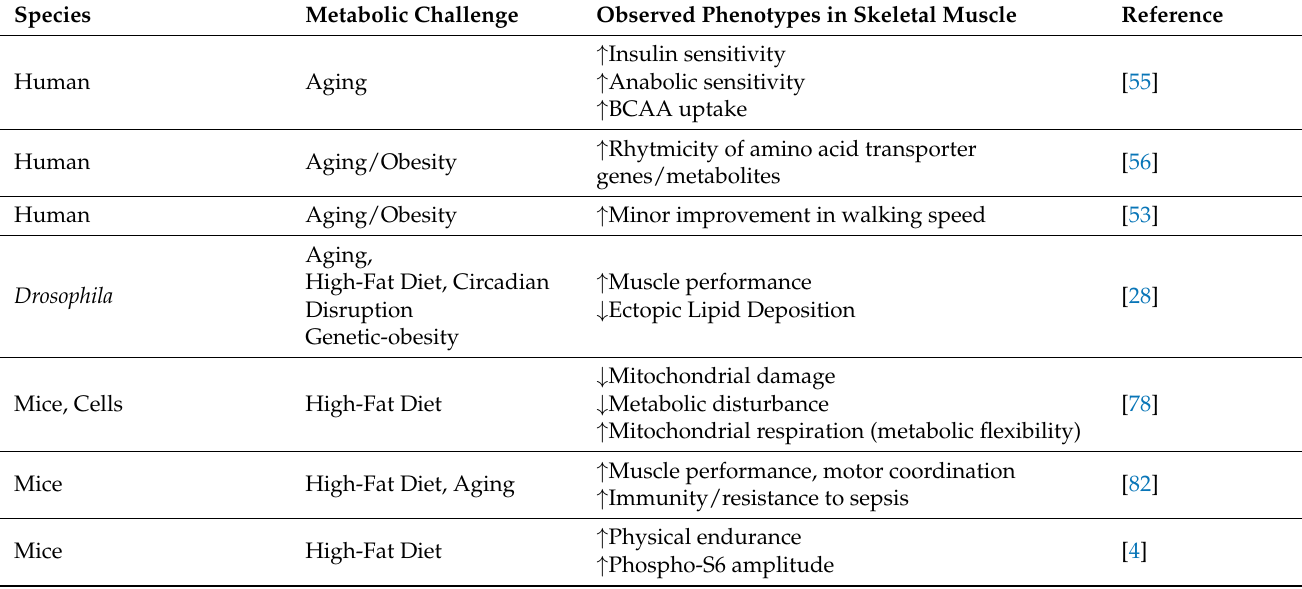
Figure 2. Muscle-specific TRE/TRF-mediated benefits under obesogenic challenges. Studies from human and animal models (mice and flies) show that time-restricted eating/feeding improves muscle structure, function, and metabolism in the context of different obesogenic challenges. Images created in Biorender. Table 1. TRF/TRE benefits found in muscle under different metabolic challenges. Up and down arrows reflect up and down-regulation of indicated parameters respectively under